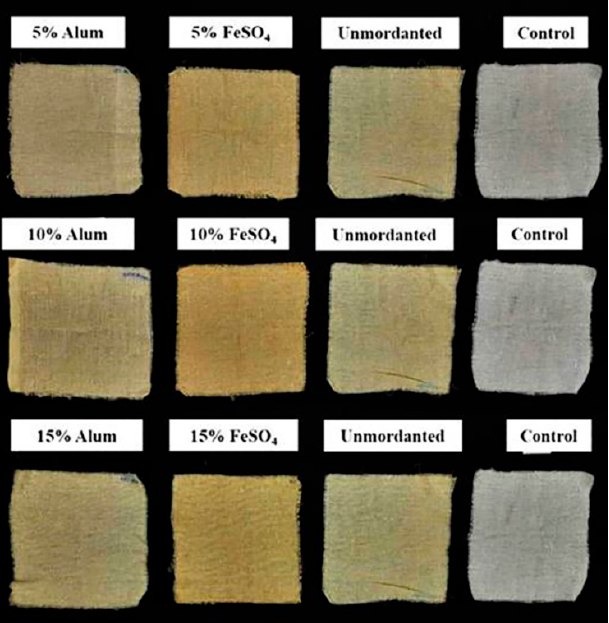
Figure 13. Cotton fabrics dyed with crude pigment extract of G. triuniae NFCCI 4873.